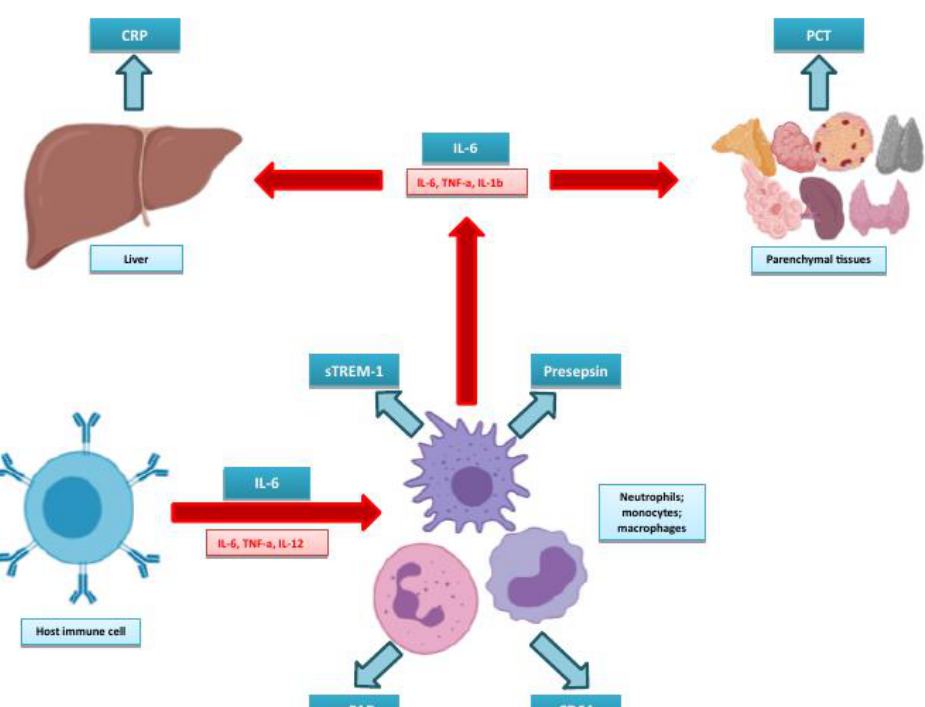
Figure 3. The origins of sepsis biomarkers in relation to the pro-inflammatory cascade activated during sepsis. CRP: C-reactive protein; CD64: cluster of differentiation 64; IL-6: interleukin-6; PCT: procalcitonin; sTREM-1: soluble triggering receptor expressed by myeloid cells-1.